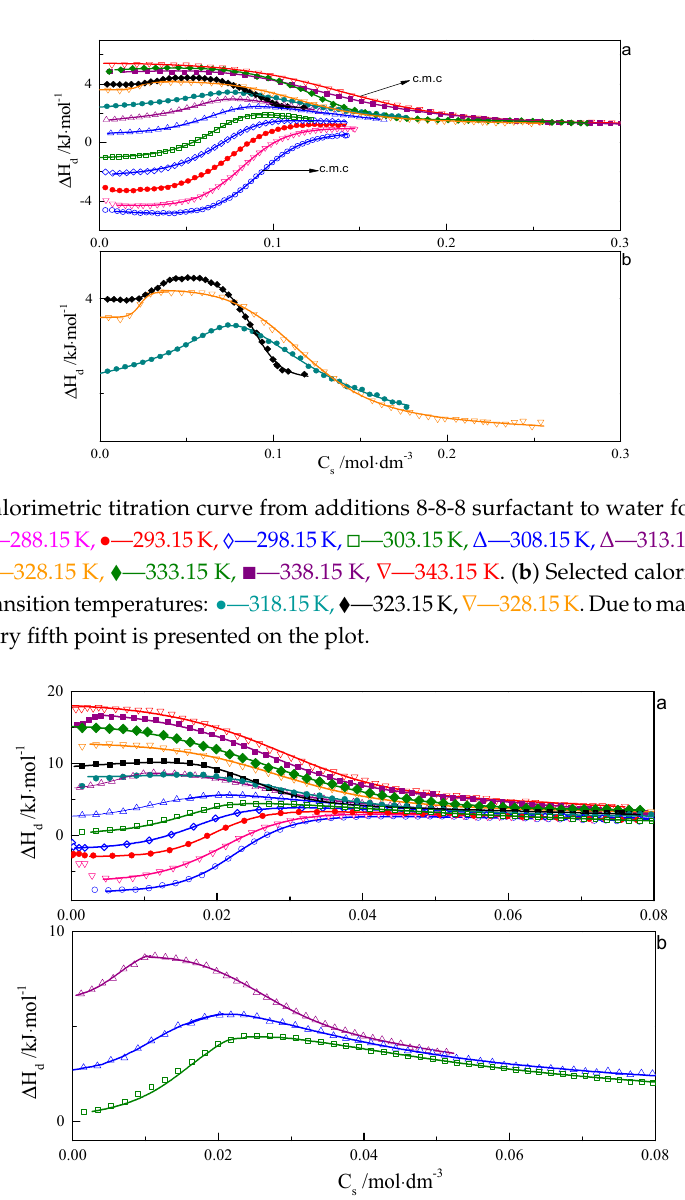
Figure 2. ( a ) Calorimetric titration curve from additions 8-14-8 surfactant to water for temperatures: ○ —283.15 K, ∇ —288.15 K, • —293.15 K, —298.15 K, □ —303.15 K, ∆ —308.15 K, ∆ —313.15 K, • —318.15 K, ♦ —323.15 K, ∇ —328.15 K, ♦ —333.15 K, ■ —338.15 K, ∇ —343.15 K. ( b ) Selected calorimetric titration curves for the transition temperatures: □ —303.15 K, ∆ —308.15 K, ∆ —313.15 K. Due to many